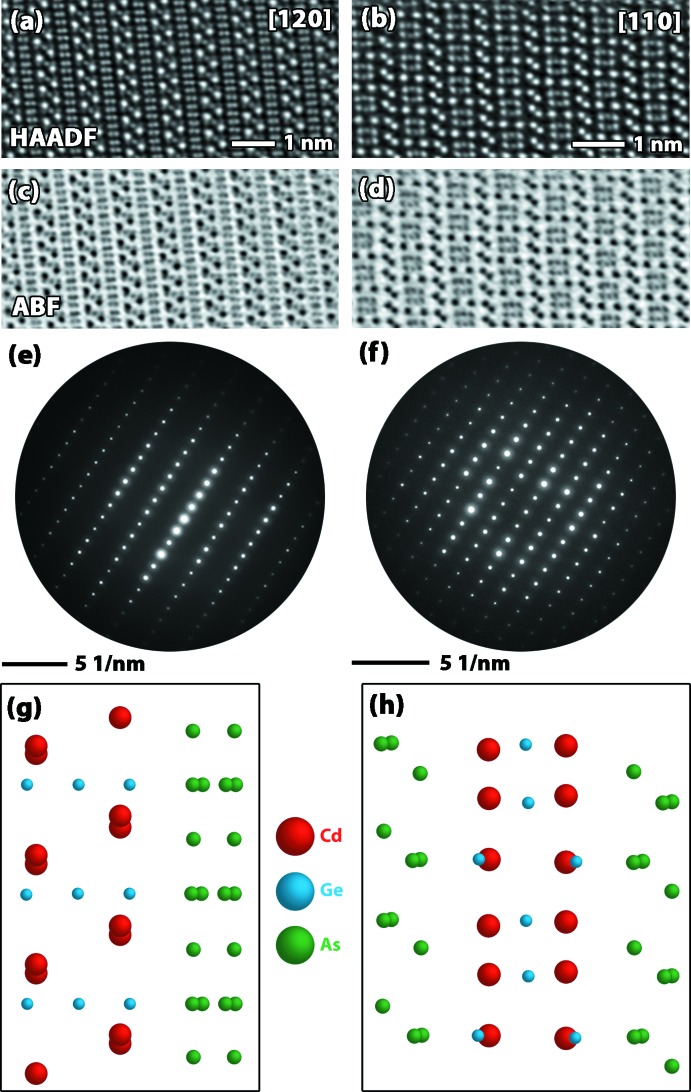
(a)–(d) Atomic-resolution column micrographs in STEM (a),(b) HAADF and (c),(d) ABF imaging modes as well as the (e),(f) selected area diffraction and (g),(h) corresponding atomic identifications for each pole (i.e., [120] on the left and [110] on the right).